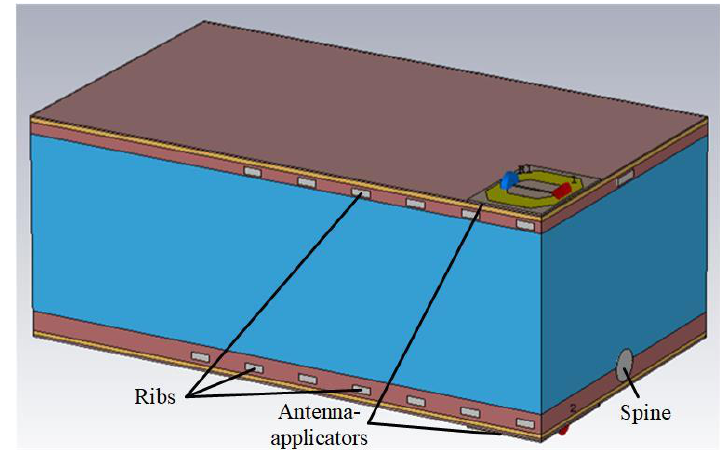
Fig. 2. Model of the chest area, with antenna applicators.